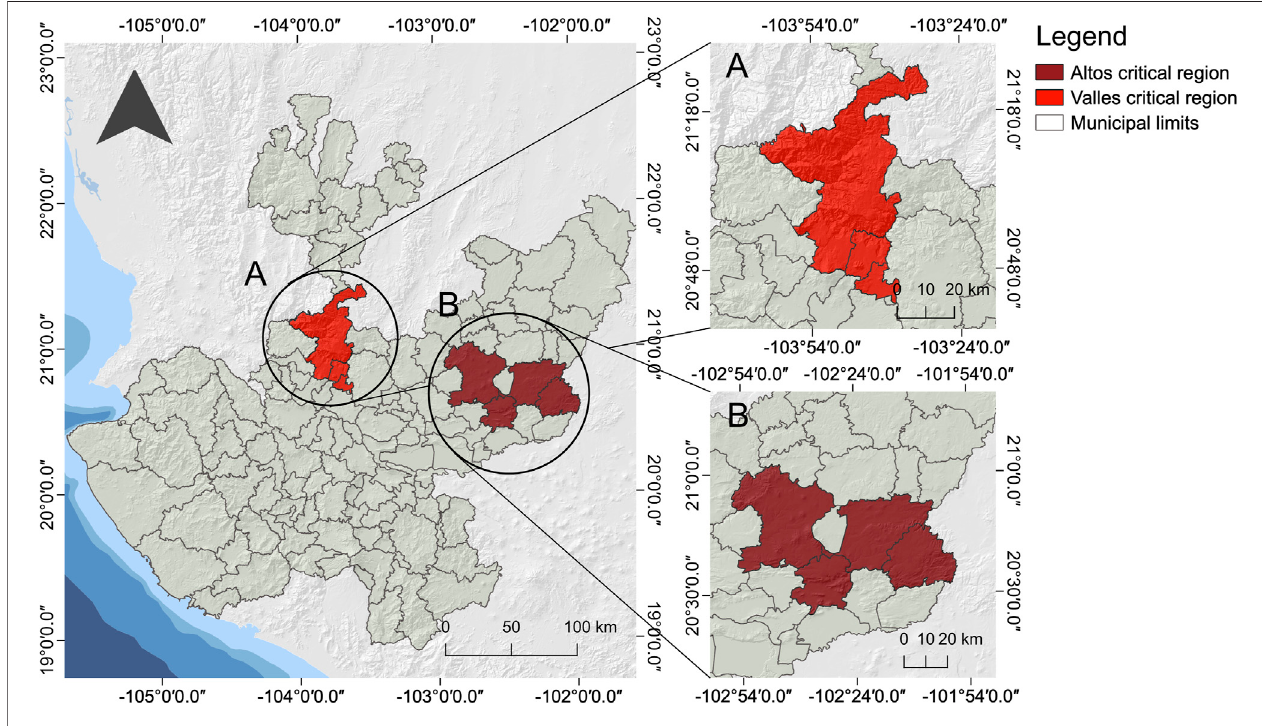
FIGURE 5 | Critical regions established according to municipal limits.